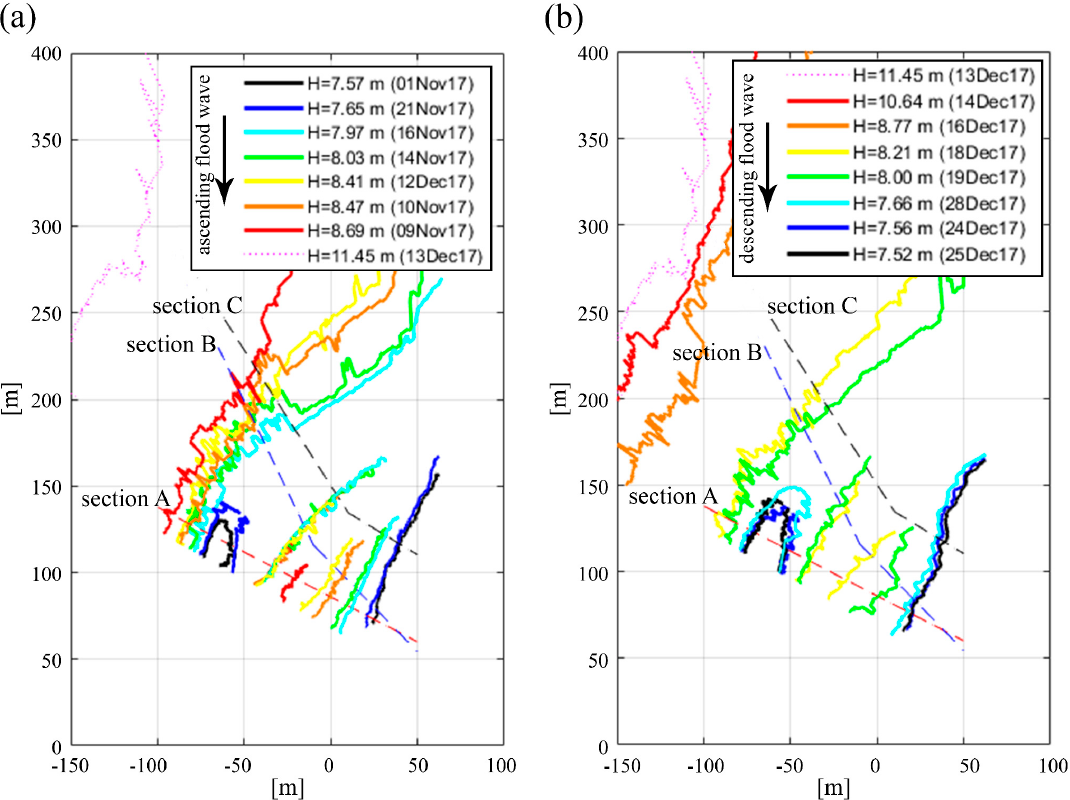
Figure 7. Riverine edge-of-water lines during the ( a ) ascending and ( b ) descending waves of the flooding event of December 13 (magenta pointed line). The dashed lines locate the three cross sections used to evaluate the morphological changes.